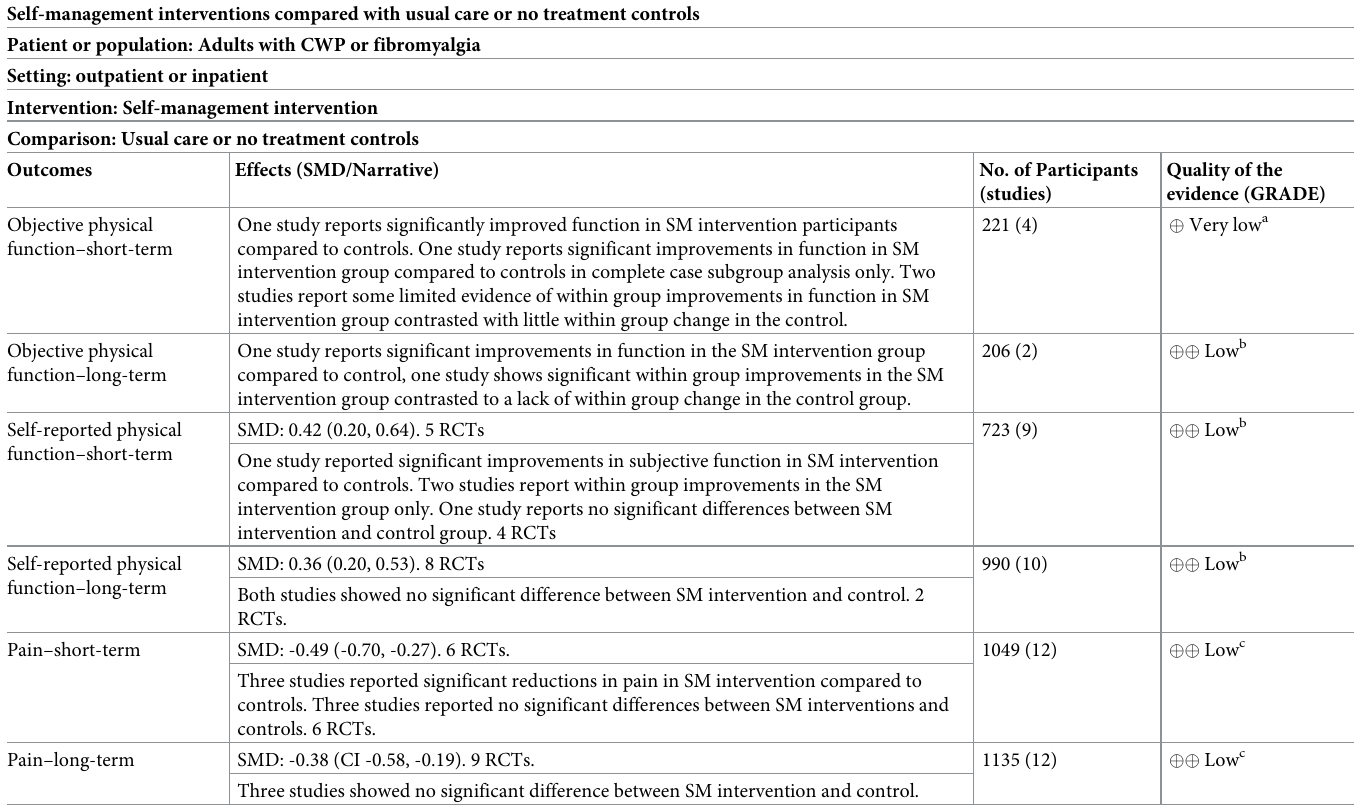
Table 2. Summary of findings: Self-management interventions for chronic widespread pain (CWP) including fibromyalgia. Self-management interventions compared with usual care or no treatment